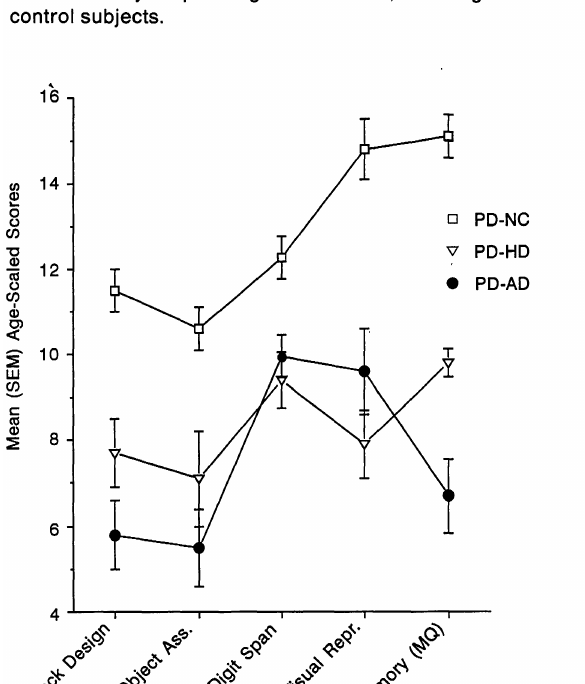
FIG. 2. Comparison of three Parkinson's subgroups identified with the discriminant formula developed from the criterion sample.